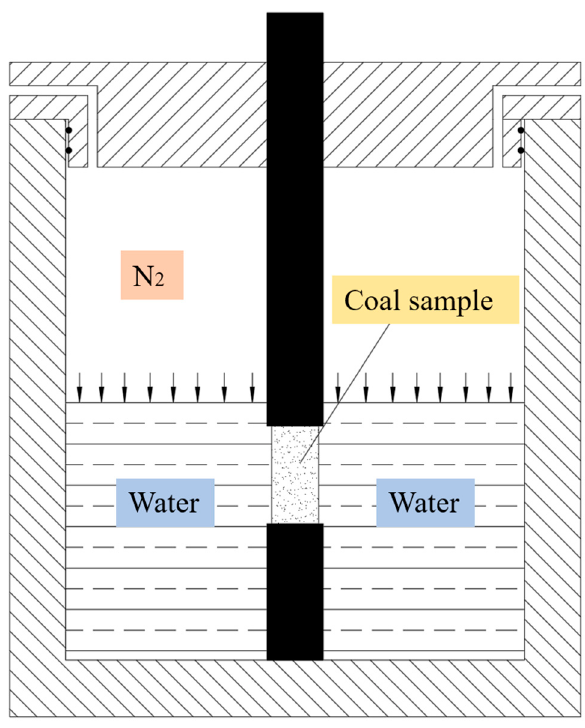
Figure 8. Schematic diagram of pore pressure loading mode.